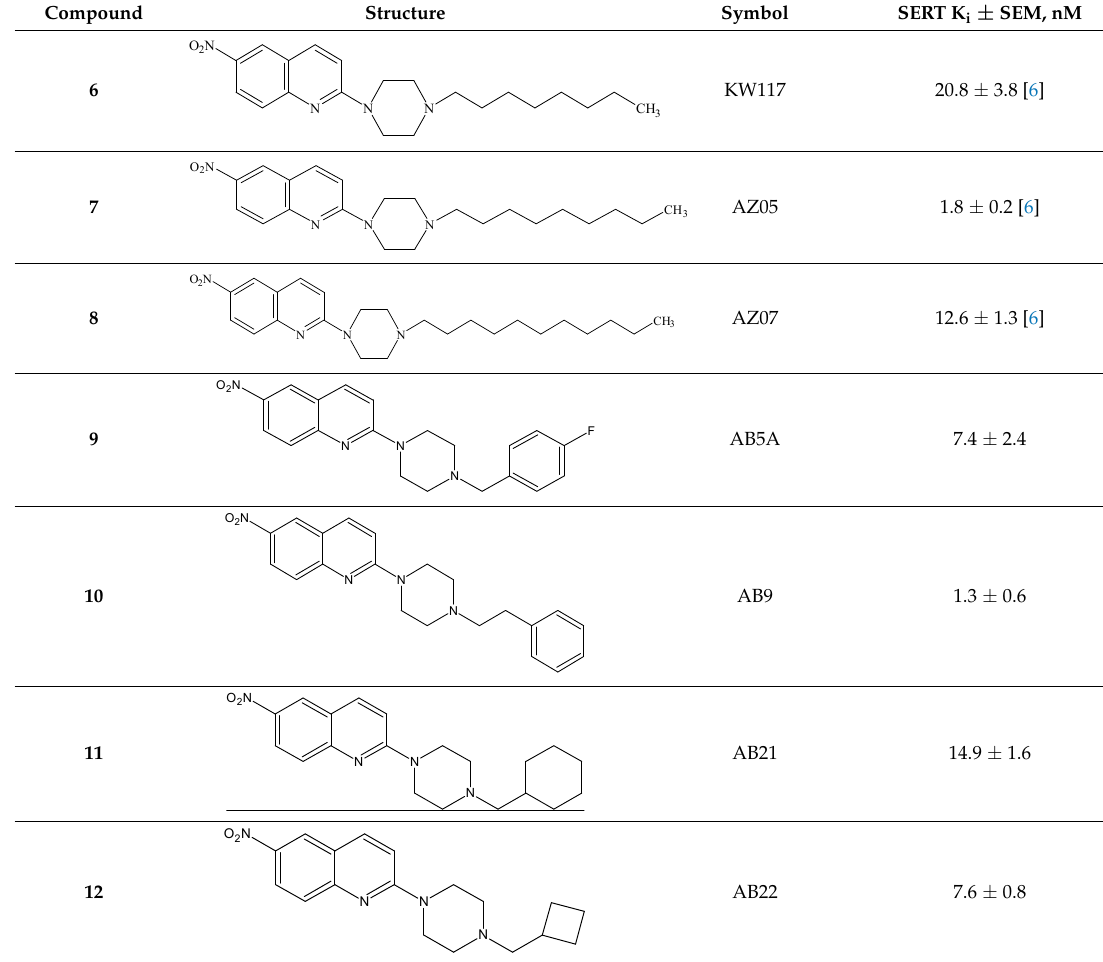
SEM—standard error of the